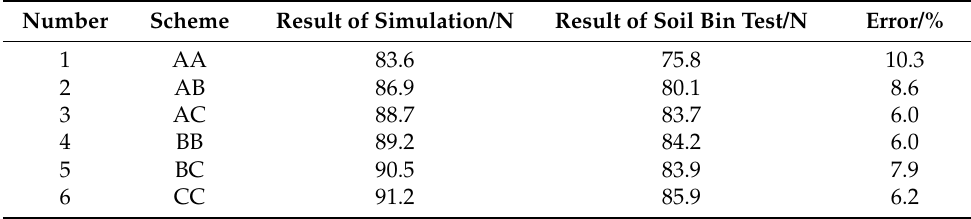
Table 8. Traction error analysis of simulation and soil bin